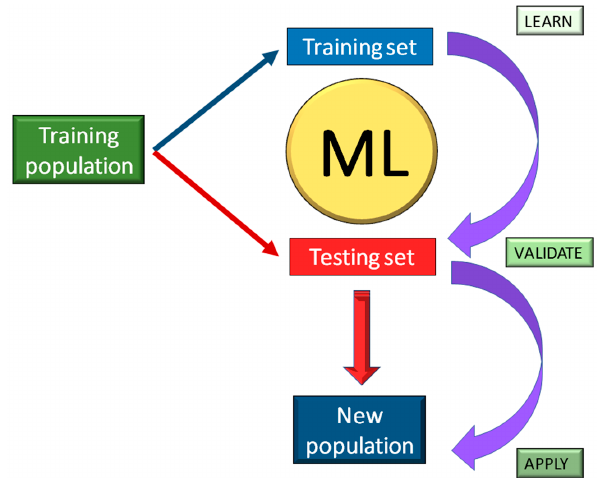
Figure 3 . Flow chart of a Machine-Learning (ML) approach. A training population in divided in a training set (where ML makes prediction) and in a testing set (where ML validates the results and its accuracy is estimated). The validated model may now be applied to a new population.